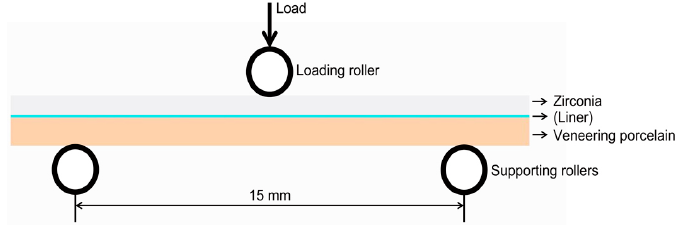
Figure 3. Three-point flexural strength test specimen and test system in a universal testing machine.